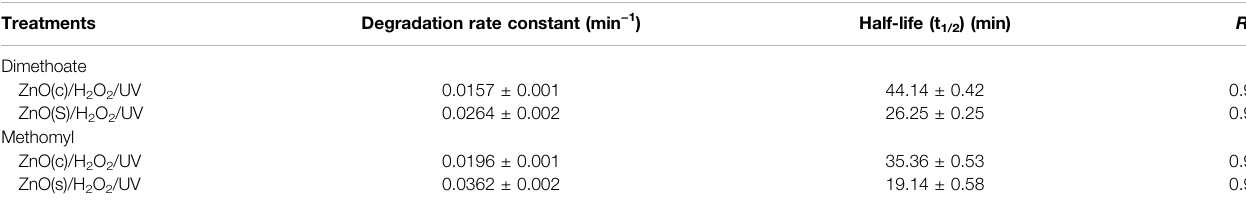
TABLE 1 | Calculated degradation rate constant and half-life values of dimethoate and methomyl under ZnO(c)/H 2 O 2 /UV and ZnO(s)/H 2 O 2 /UV systems.